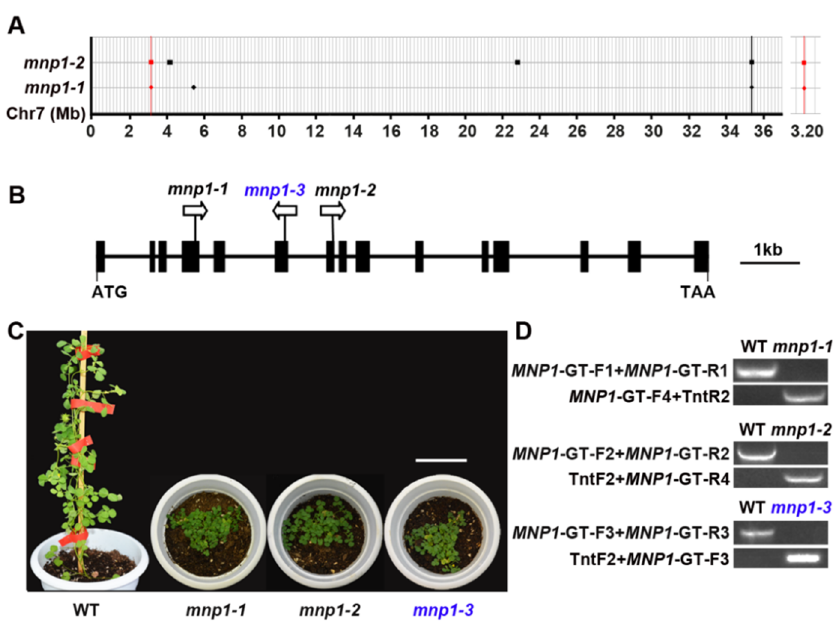
Figure 2. Molecular cloning of the MNP1 gene. ( A ) Adjacent Tnt1 insertion sites were found on chromosome 7 of mnp1-1 and mnp1-2 . The x -axis represents chromosome 7. Rhombus and squares represent Tnt1 insertions in mnp1-1 and mnp1-2 , respectively. The rhombus and square on a black line show nearby Tnt1 insertions in an intergenic region. The rhombus and square on a red line show nearby Tnt1 insertions in Medtr7g011663 and the right image is an enlarged view in the same region. ( B ) Schematic illustration of MNP1 gene structure and Tnt1 insertion sites in mnp1 alleles. The mnp1-3 (blue color) mutants were screened from the Tnt1 population using a reverse genetics approach. Filled black boxes represent exons and lines between them denote introns. Arrows indicate Tnt1 orientation. ( C ) The phenotype of mnp1 alleles. Scale bar = 6.5 cm. ( D ) Genotyping of mnp1 alleles. The primers ( MNP1 -GT-F / R) were designed for detecting MNP1 genomic fragments, and the primer pair TntF2 / R2 were Tnt1 -specific